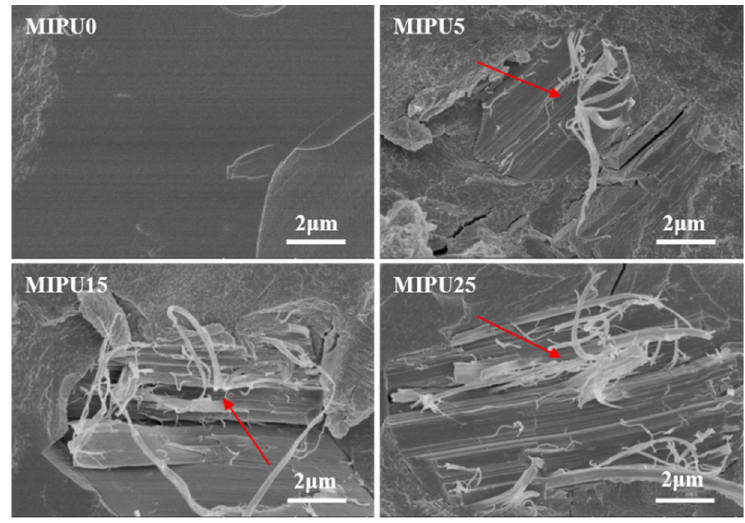
Figure 4. Morphology of the cross-sections of the coatings.